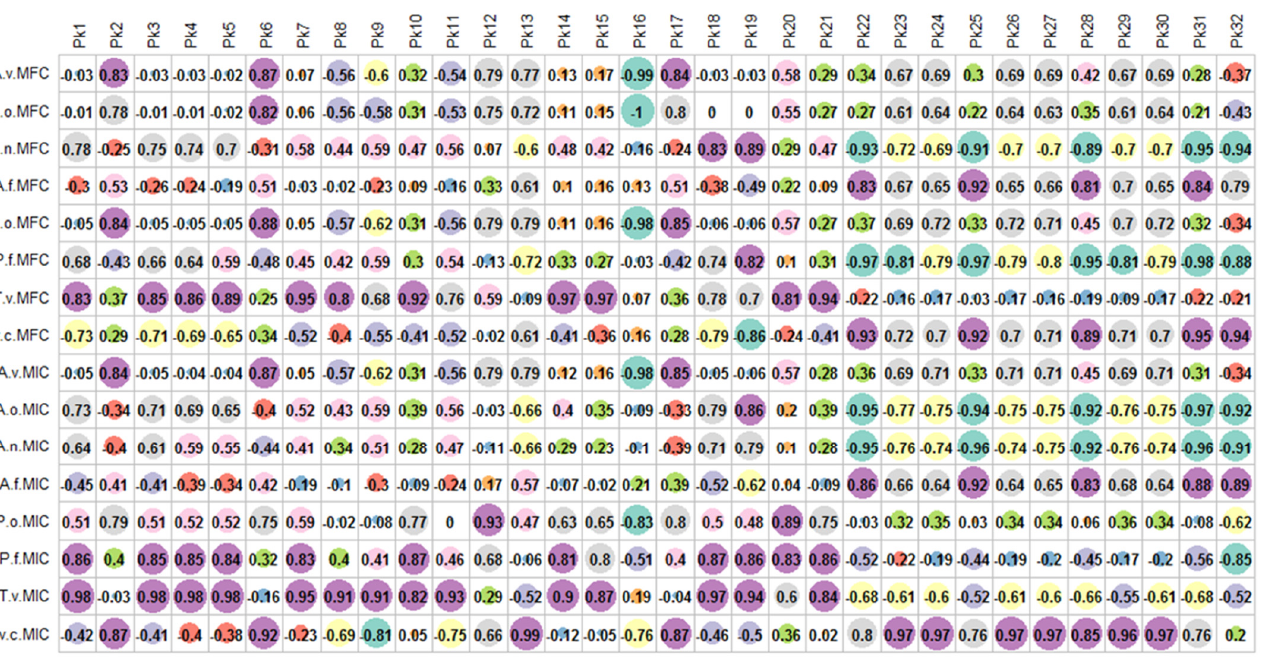
Figure 3. Relationship between phytochemical compounds and antifungal activities.